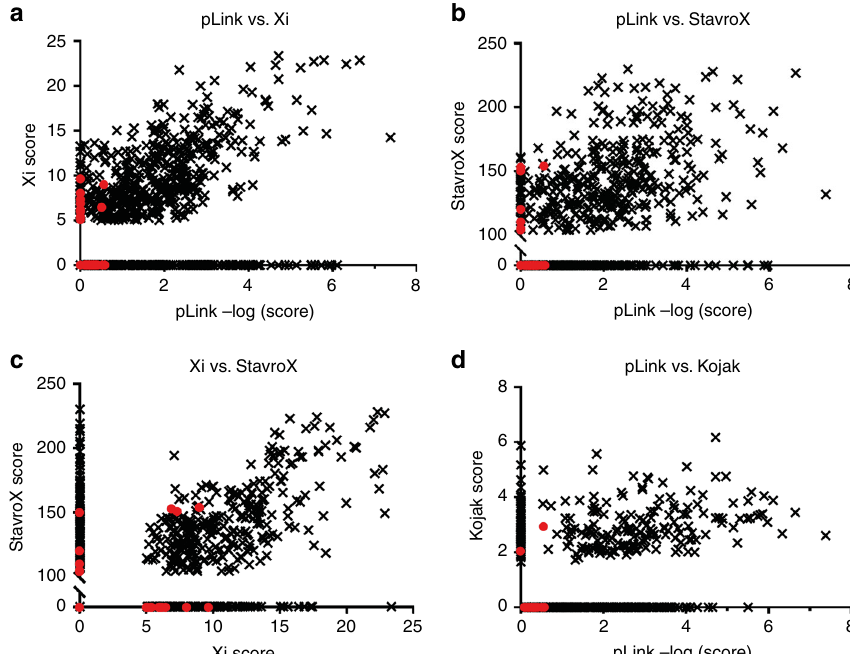
Fig. 4 Comparison of scores assigned to each CSM by pLink, StavroX, Xi and Kojak. CSMs correlating to correct crosslinks are shown in black, and CSMs correlating to false positives are shown in red. a pLink vs. Xi, b pLink vs StavroX, c Xi vs StavroX, and d pLink vs